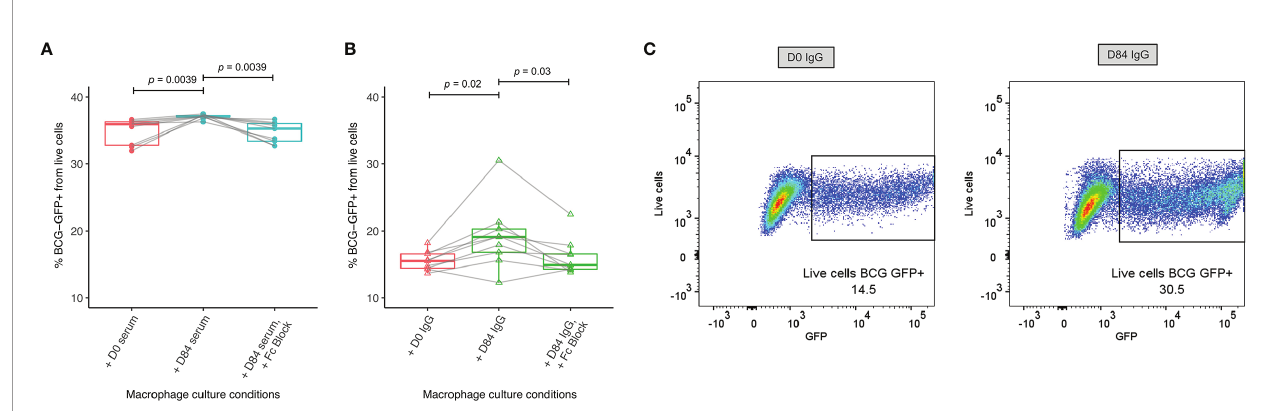
FIGURE 6 | Enhanced macrophage phagocytosis of BCG-GFP with sera or puri fi ed IgG following BCG vaccination. Samples were used from n=9 healthy UK adults enrolled into human Study 1. Antibody-dependent cellular phagocytosis was measured using human THP-1 derived macrophages and serum (A) or puri fi ed IgG (B) from baseline and 84 days post-BCG vaccination and the percentage of BCG-GFP that was phagocytosed was determined by fl ow cytometry. Points represent the mean of duplicate values, boxes indicate the median value with the interquartile range (IQR) and the upper whisker extends to the largest value no further than 1.5 * IQR from the hinge, the lower whisker extends from the hinge to the smallest value at most 1.5 * IQR from the hinge. Outliers are plotted individually. A Wilcoxon matched-pairs test was used to compare between time-points. Flow plots are shown from a single replicate of one subject at baseline and 84 days post-BCG vaccination using puri fi ed IgG (C)